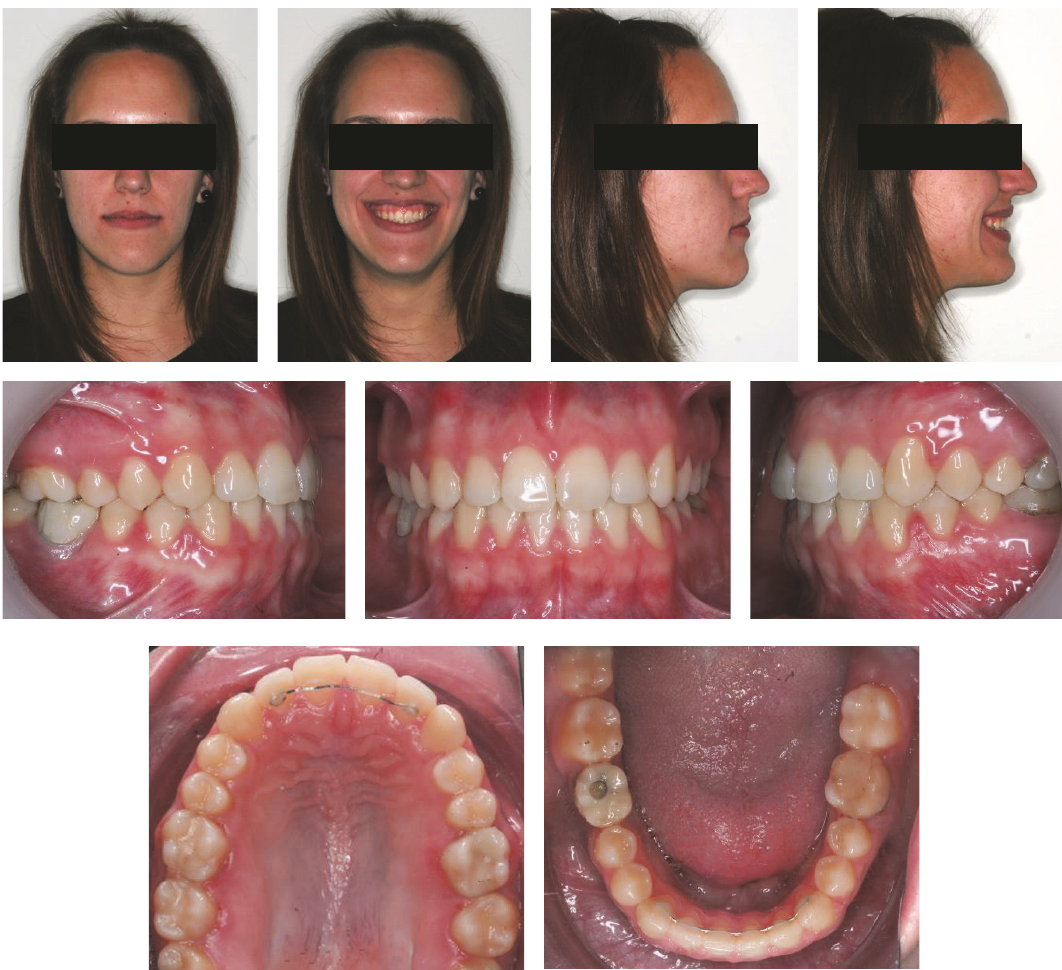
Figure 6: Intra- and extraoral final